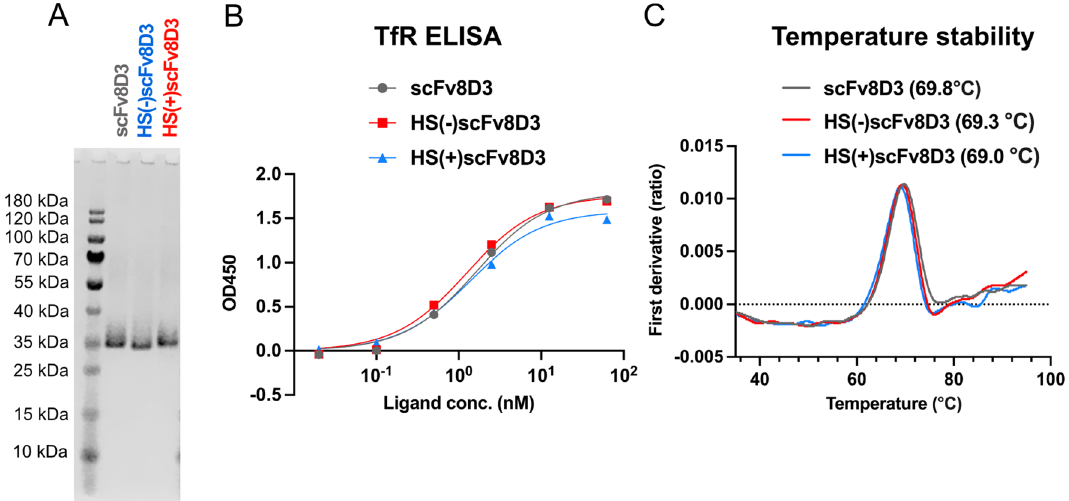
Figure 3. Characterization of purity, functionality and thermostability of scFv constructs. ( A ). SDS-PAGE of the purified scFvs showing a single band at the expected size of 31 kDa, for scFv8D3, HS(−)scFv8D3 and HS(+) scFv8D3. ( B ). Indirect ELISA showing similar scFv binding affinities to TfR. ( C ). Structural stability of the scFvs under thermal stress measured with Tycho nt.6 system starting at 30 °C. Full sized image of SDS-PAGE gel in supplementary Fig. S1.